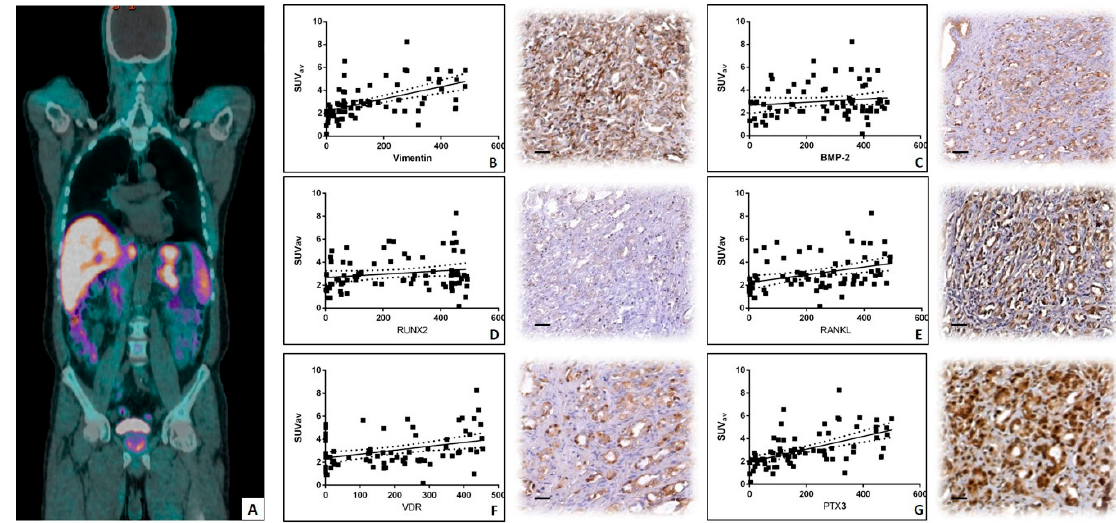
Figure 2. Comparison between 18 F–choline uptake and the expression of bone biomarkers. ( A ) 18 F-FCH PET maximum-intensity projection in a 69-year-old prostate cancer patient. ( B ) Graph displays the positive association between SUV average and the number of vimentin-positive cancer cells ( r 2 = 0.2787; p < 0.0001). ( C ) No association is showed between SUV average and the number of bone morphogenetics protein (BMP)-2 positive prostate cancer cells. ( r 2 = 0.01715; p = 0.2595). ( D ) No association is displayed between SUV average and the number of runt-related transcription factor 2 (RUNX2) positive cancer cells ( r 2 = 0.03013; p = 0.1337). The RUNX2 reaction shows intense nuclear staining. ( E ) The graph displays the positive association between SUV average and the number of receptor activator of nuclear factor- κ B ligand (RANKL) positive cancer cells ( r 2 = 0.1259; p = 0.0017). ( F ) The graph shows the positive association between SUV average and the number of vitamin D receptor (VDR) positive cancer cells ( r 2 = 0.1227; p = 0.0019); Intense nuclear VDR positivity is shown. ( G ) A positive association between SUV average and the number of PTX3 positive cancer cells is displayed ( r 2 = 0.3081; p < 0.0001). Scale bar represents 10 µ m in each image.